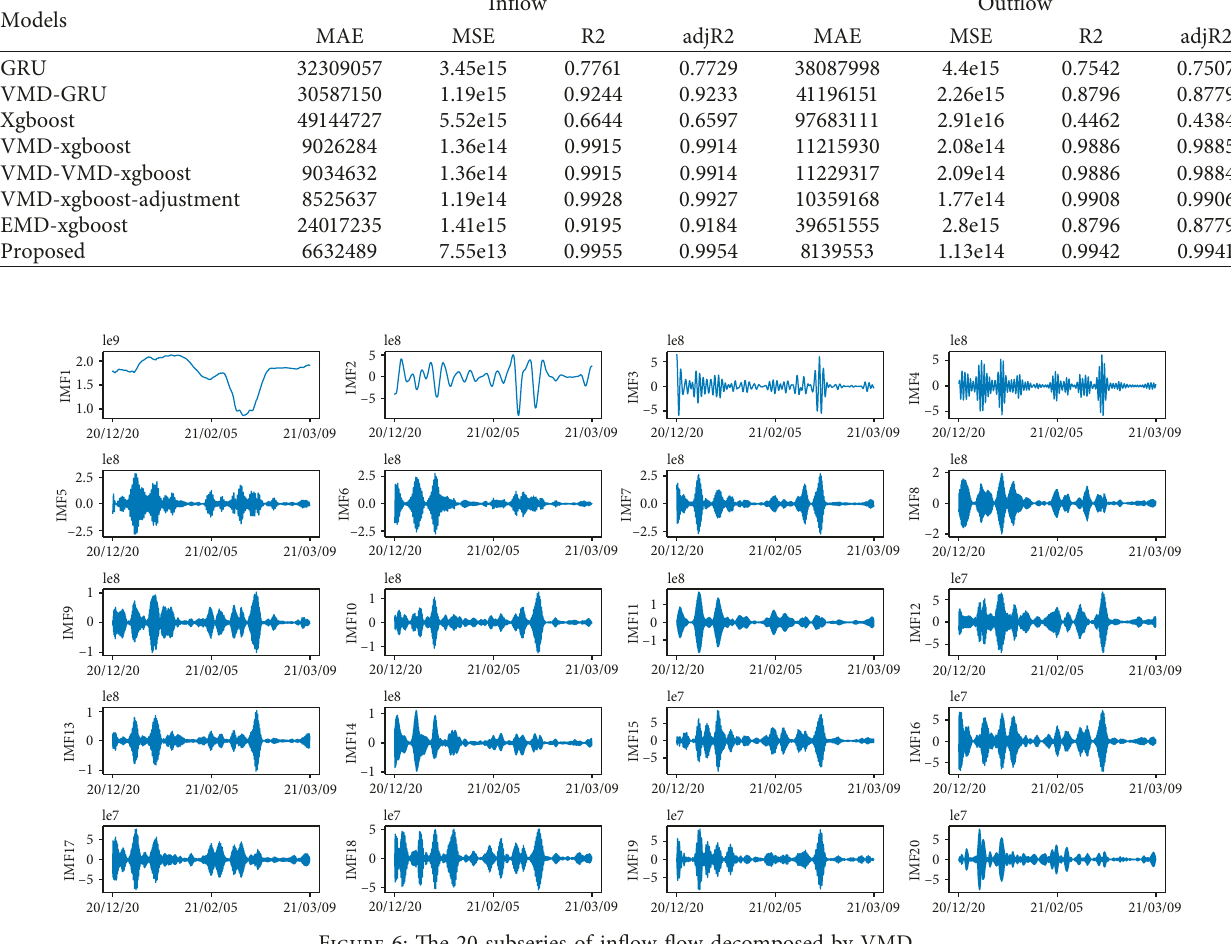
Figure 6: The 20 subseries of inflow flow decomposed by VMD.